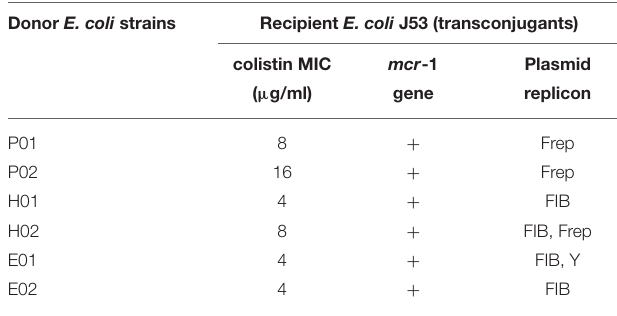
TABLE 3 | The characteristics of transconjugants after treatment with CFS of LAB.